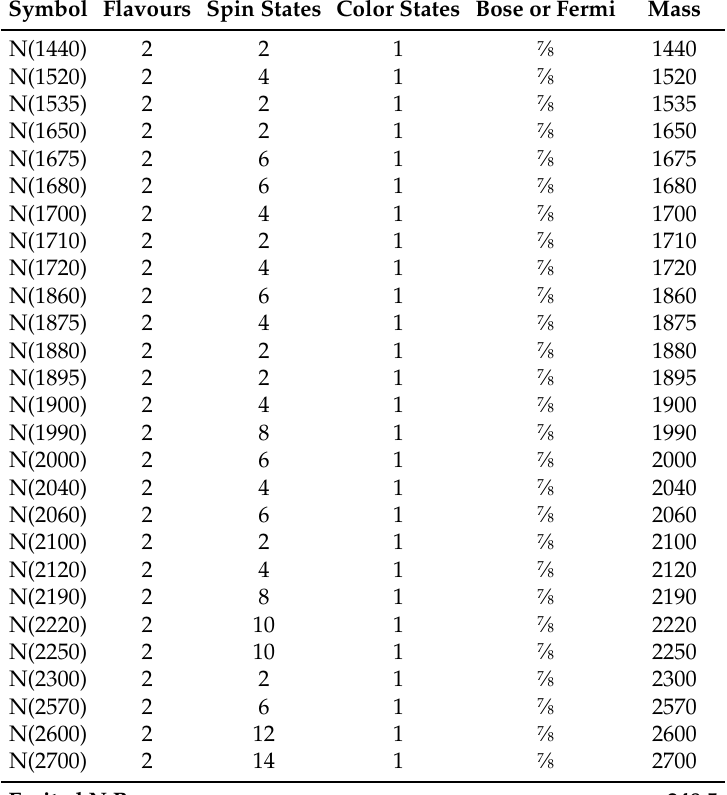
Table D3. Excited N